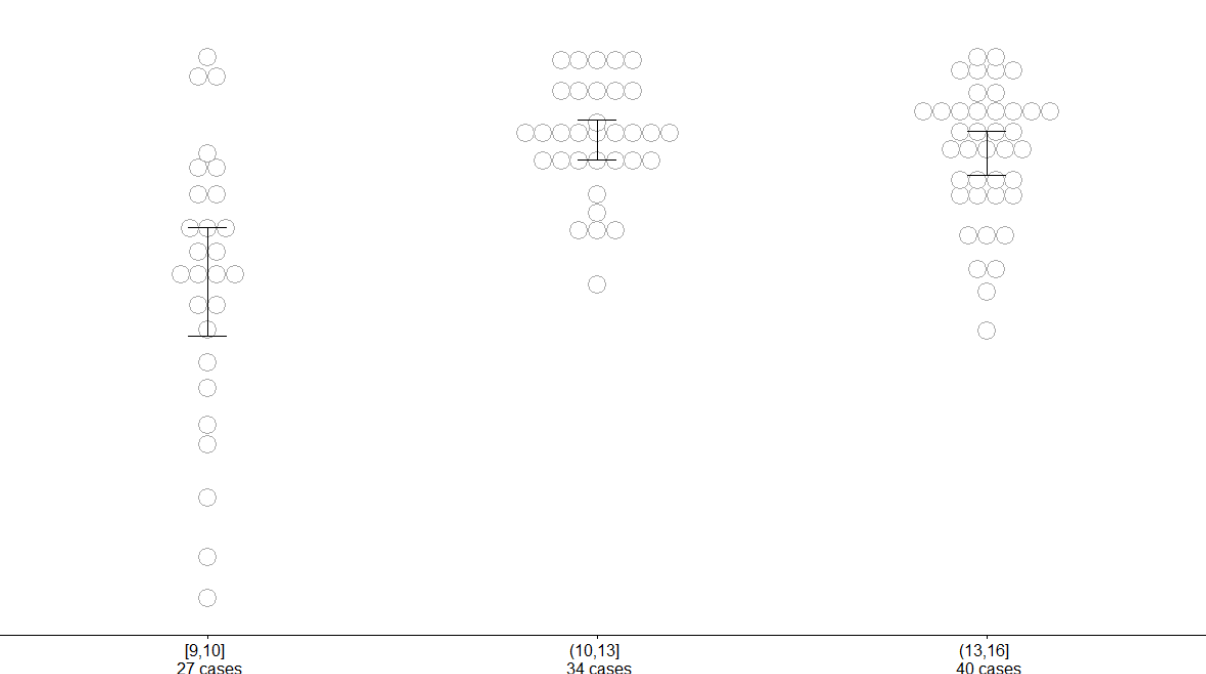
Figure 2. Total SSQ for children’s score as a function of age.